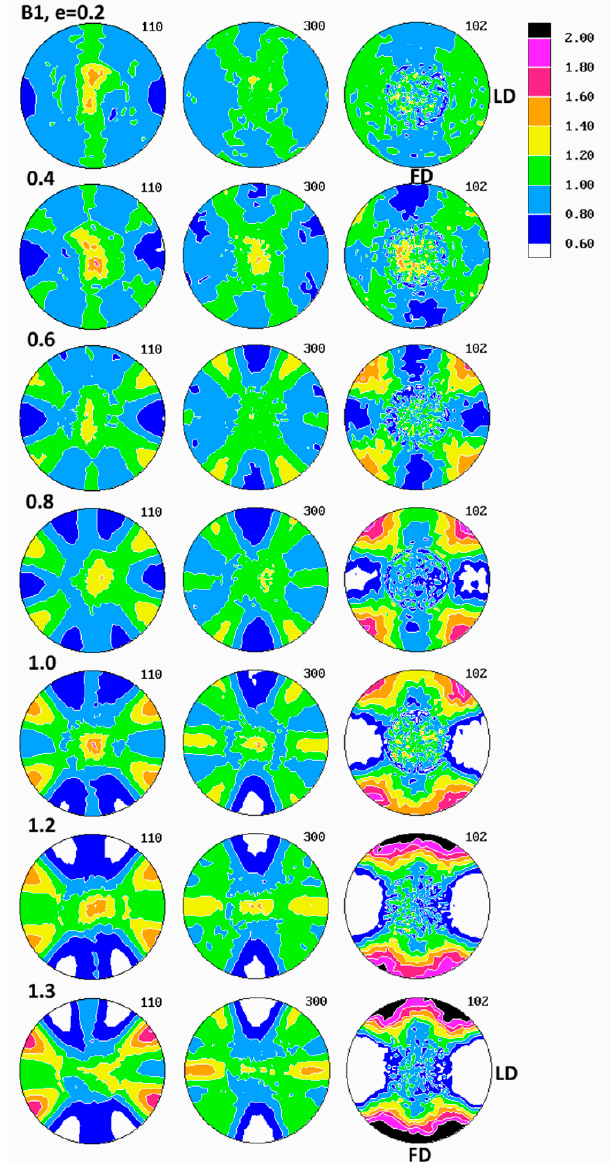
Figure 6. Normalized pole figures of the (110) (300) and (102) crystallographic planes (Form I) determined for samples of B1 homopolymer compressed in plane-strain to the true strain indicated. Linear scale in the m.r.d. units.